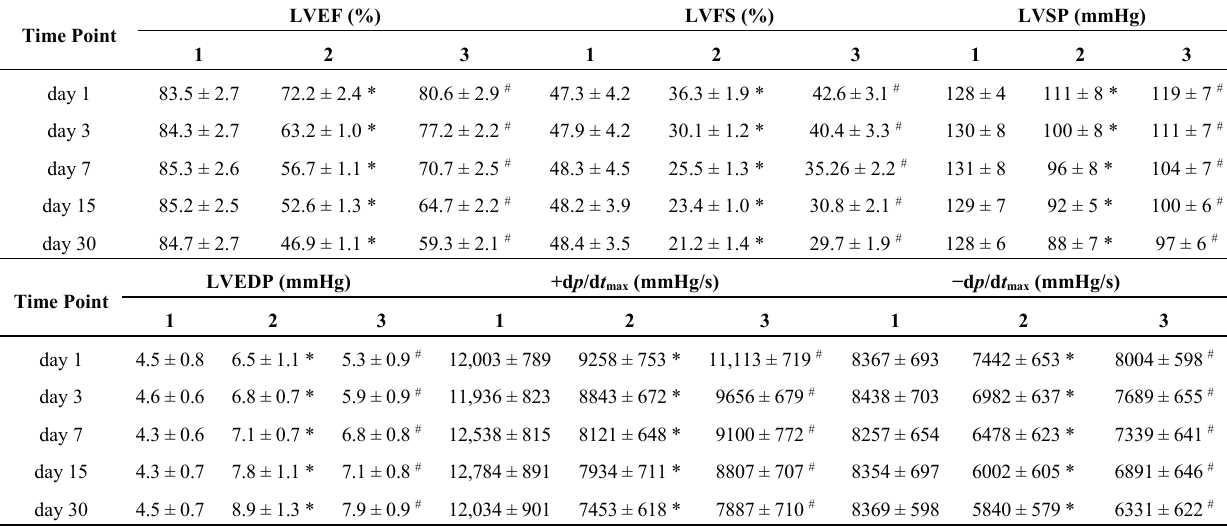
Table 1. Differences in cardiac function of three groups. LVEF, left ventricular ejection fraction; LVFS, left ventricular fractional shortening; LVSP, left ventricular systolic pressure.